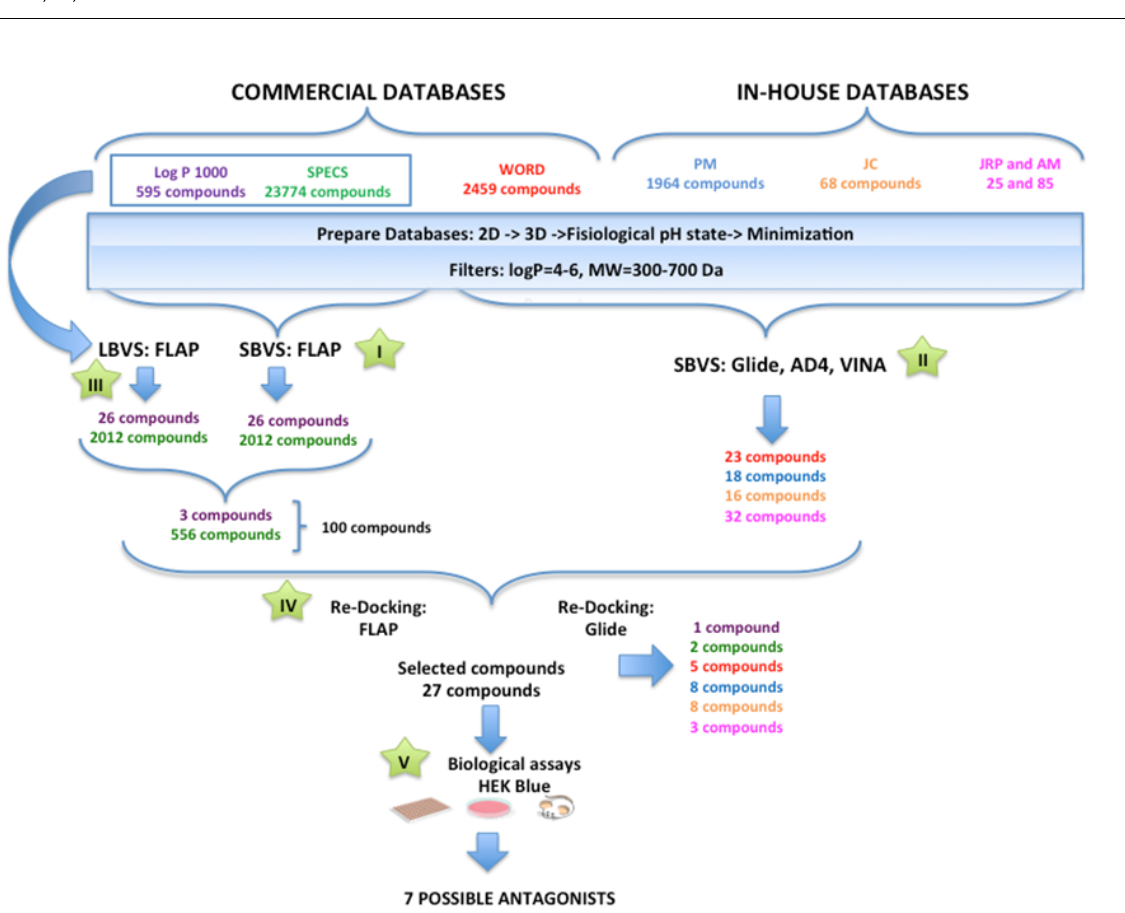
Figure 2 . Flowchart of the virtual screening, redocking, and biological assay protocol. Figure 2. Flowchart of the virtual screening, redocking, and biological assay protocol.